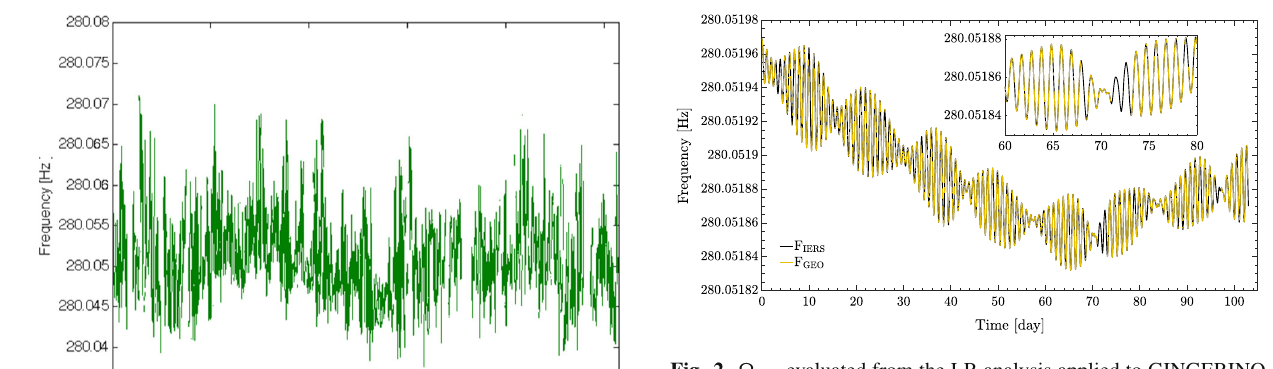
Fig. 2 (cid:3) geo evaluated from the LR analysis applied to GINGERINO data compared with K cal · (cid:3) IERS . The detail of 20 days is shown in the inset. The data removed from the analysis are evident